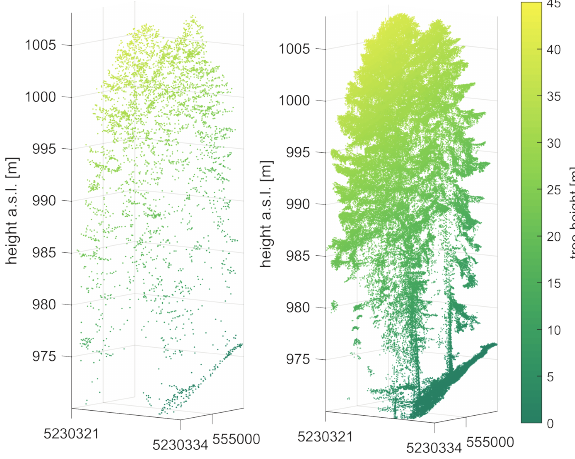
Figure 1. Oblique view onto a 14 x 10 m (northing x easting) subset of site 1, taken from the ALS (left) and the ULS (right) point cloud. The subsets are centered at 5230328.5 N, 555000 E and were taken at the original resolutions of the respective point clouds.